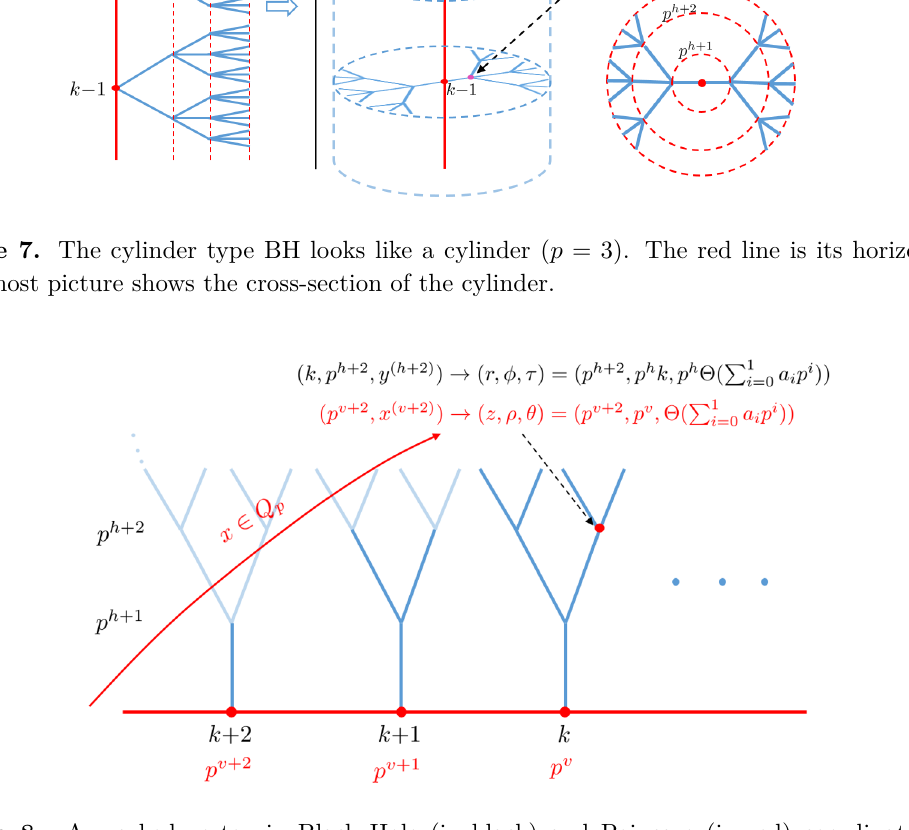
Figure 8. A marked vertex in Black Hole (in black) and Poincare (in red) coordinates. The red arrow gives the constant Poincare radial coordinate z surface. The horizon here is the “main branch” in Poincare coordinates and on which marks the radial z